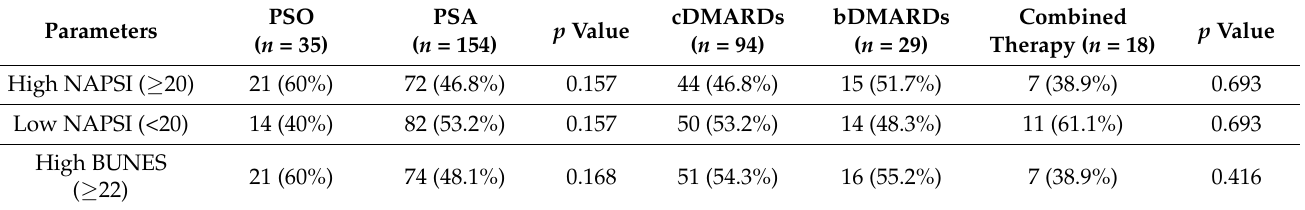
NAPSI, BUNES and GUESS values in patients with psoriatic disease receiving systemic